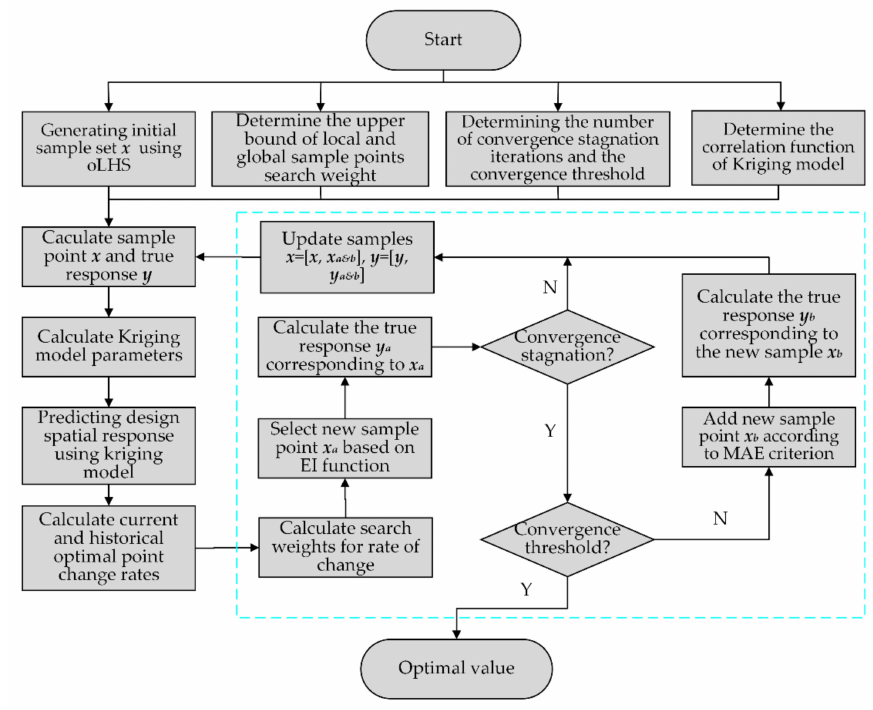
Figure 14. The IEGO algorithm